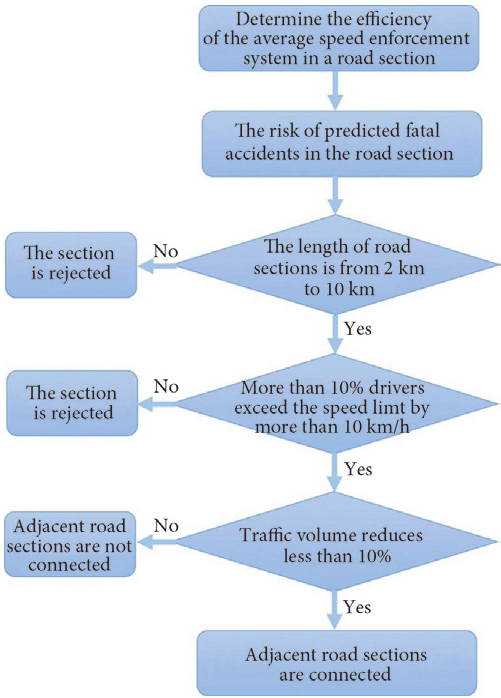
Fig. 1. Setting model of system efficiency to traffic safety on main road